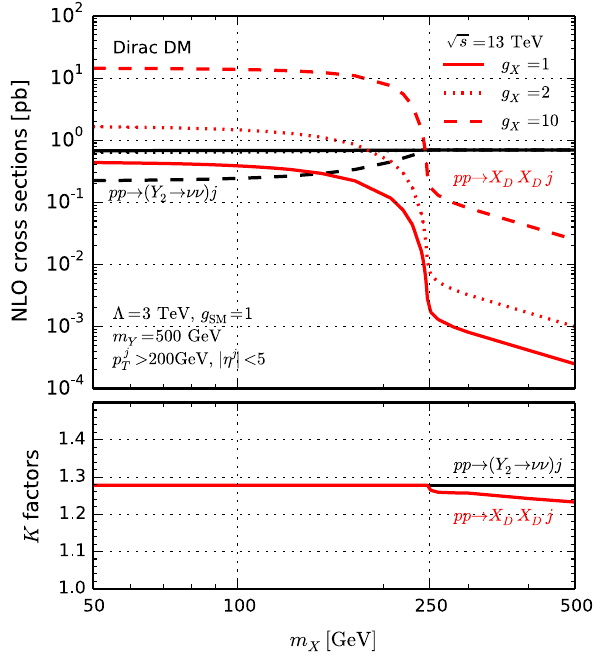
> 200 GeV and | η j | < 5 T γ > 150GeVand | η γ | < 2 . 5. T